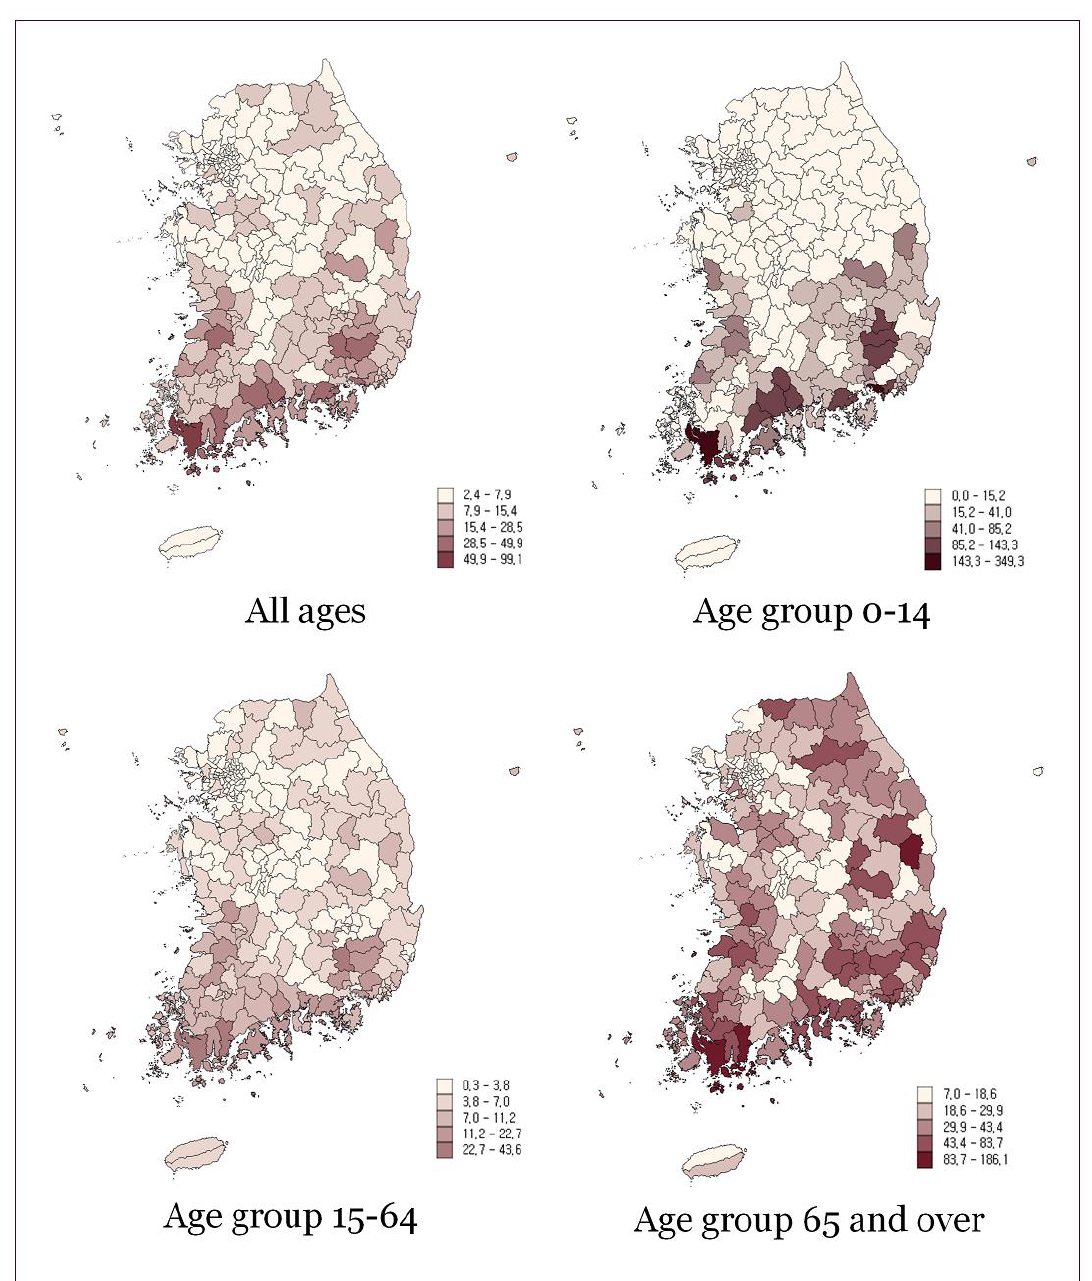
Figure 1. Hospitalization rates per 10,000 for asthma by age group.